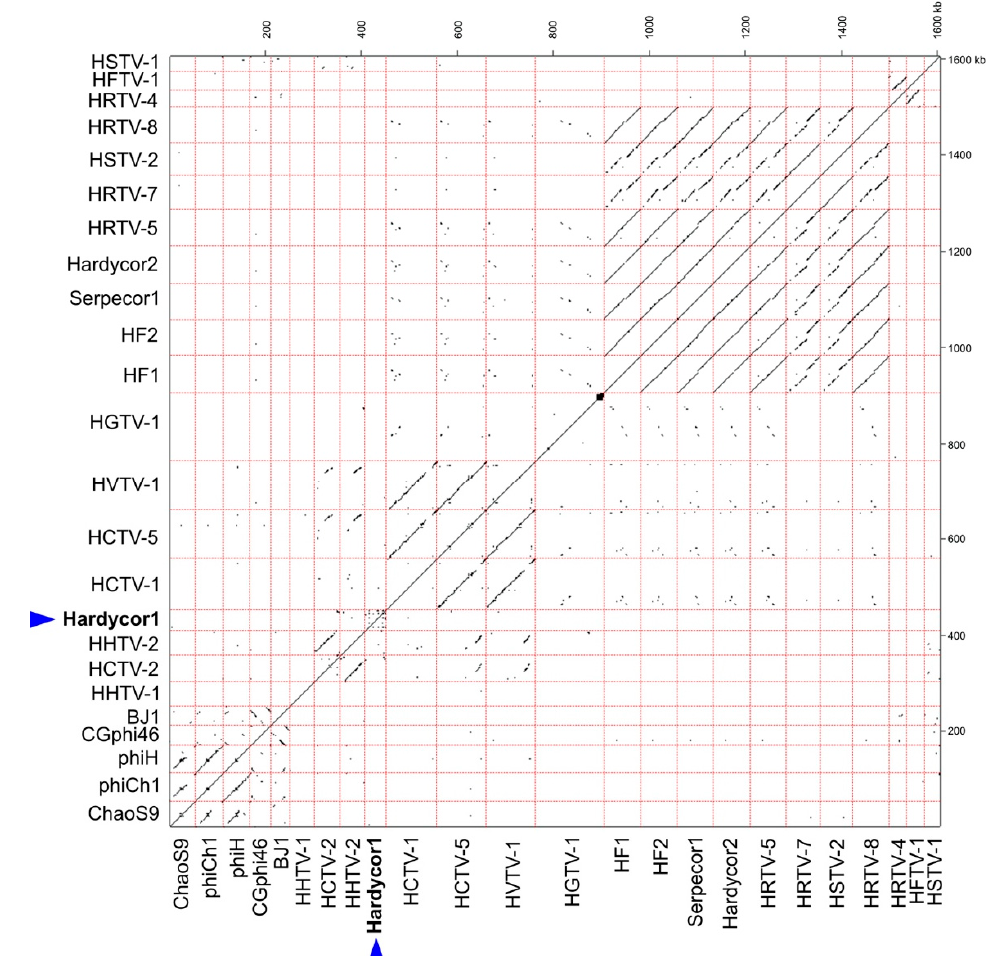
Figure 2. Dot plot comparison of the Hardycor1 genome with the genomes of 21 other tailed haloviruses. Nucleotide sequence similarity analysis was performed using YASS (BLASTz; E-value threshold = 10 − 10 ) [28]. Virus names are shown along the left and lower axes, and genome borders are shown as pink dashed lines. The position of Hardycor1 is indicated by a blue triangle. Sequence accessions for each halovirus are given in Figure 3. The scale is shown in kb along the upper and right